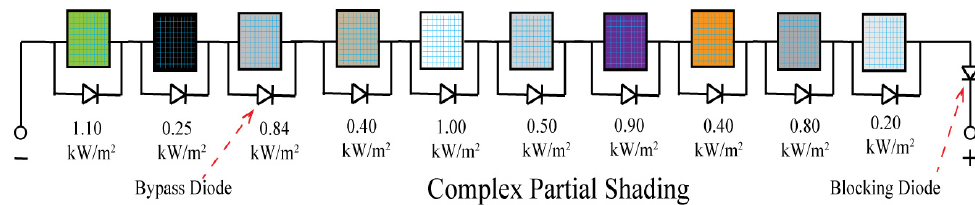
Figure 4. Complex Partial Shading